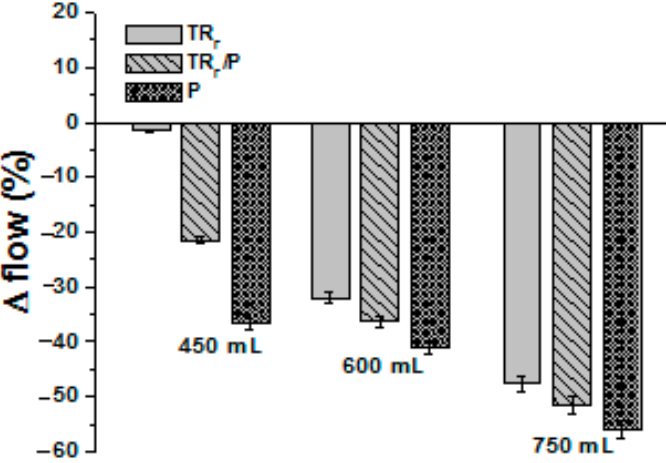
Figure 7. Flow test results of the TR F and perlite samples with respect to the normalized mortar (control).